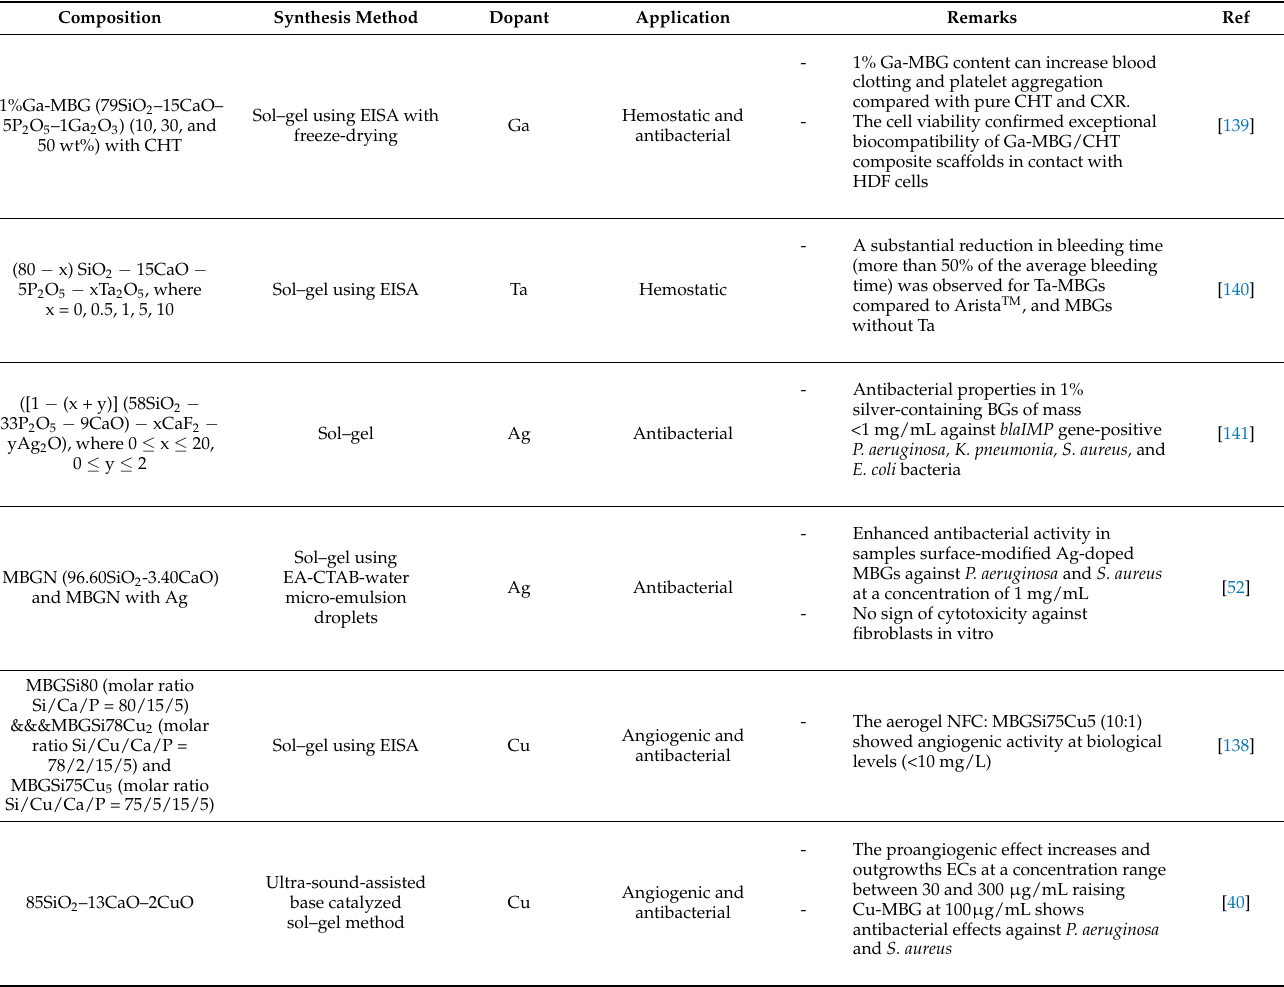
Table 1. A short list of experimental studies performed on ion-doped MBGs for potential use in wound healing.